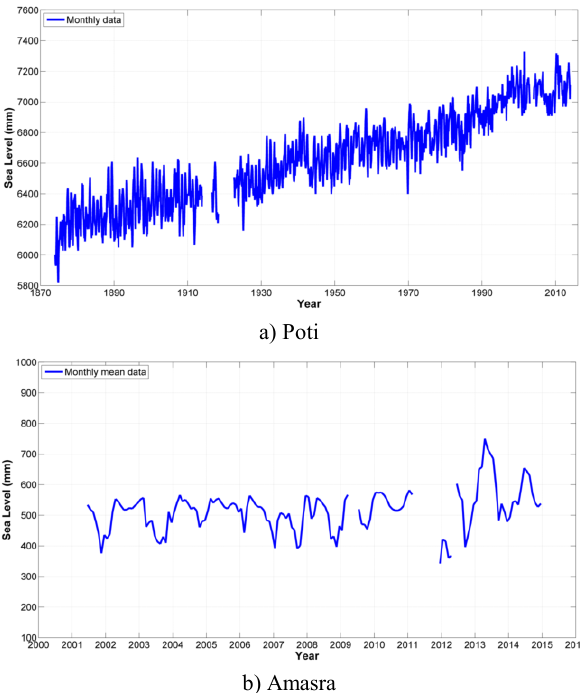
Figure 2. Monthly mean sea level changes at tide-gauge stations along the Black Sea